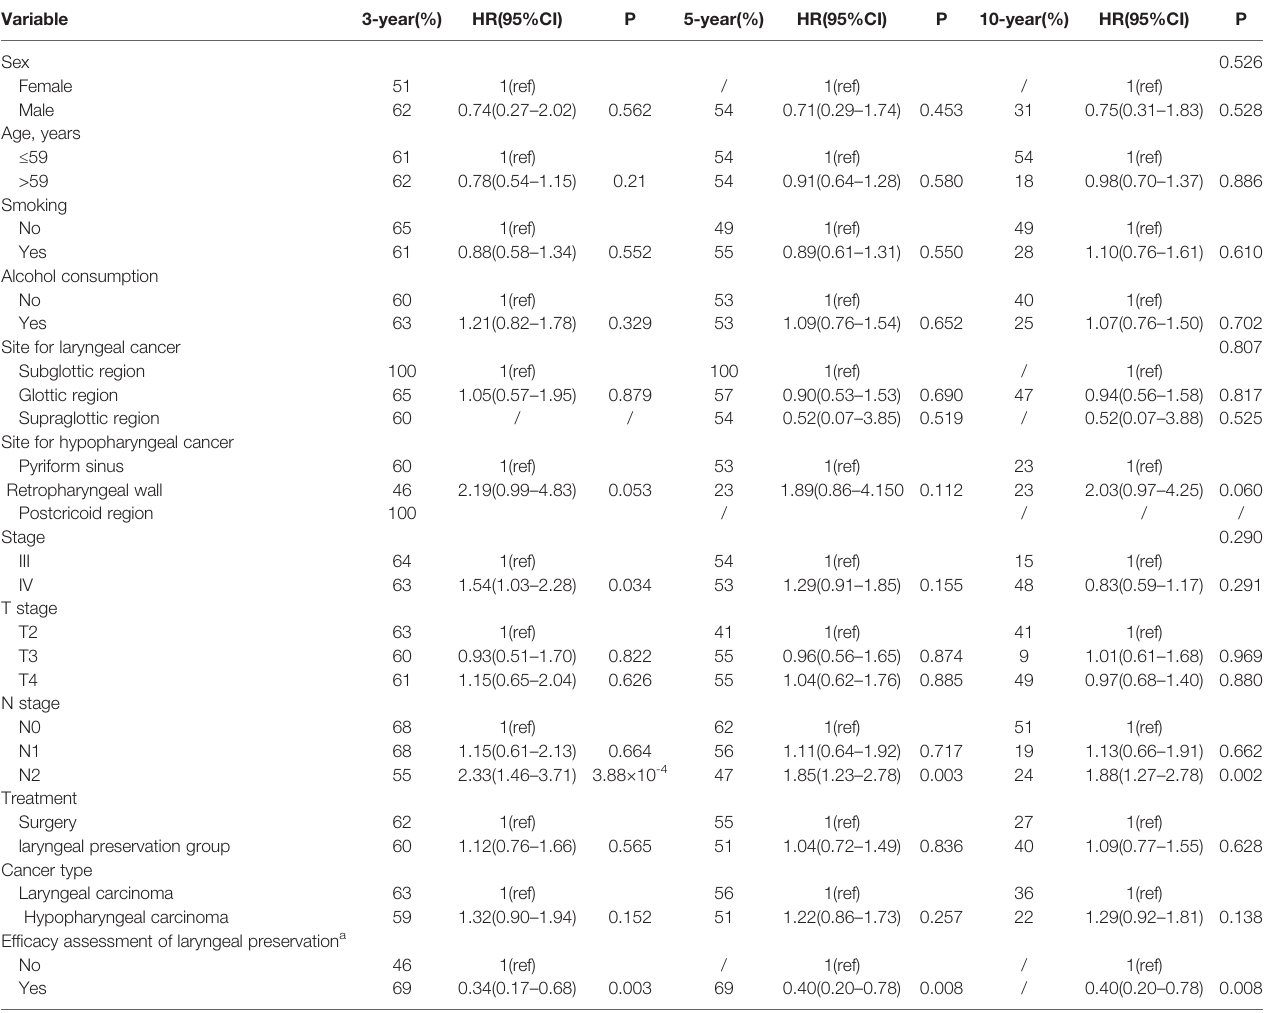
TABLE 3 | Univariate analysis of overall survival in patients with laryngeal and hypopharyngeal carcinoma.